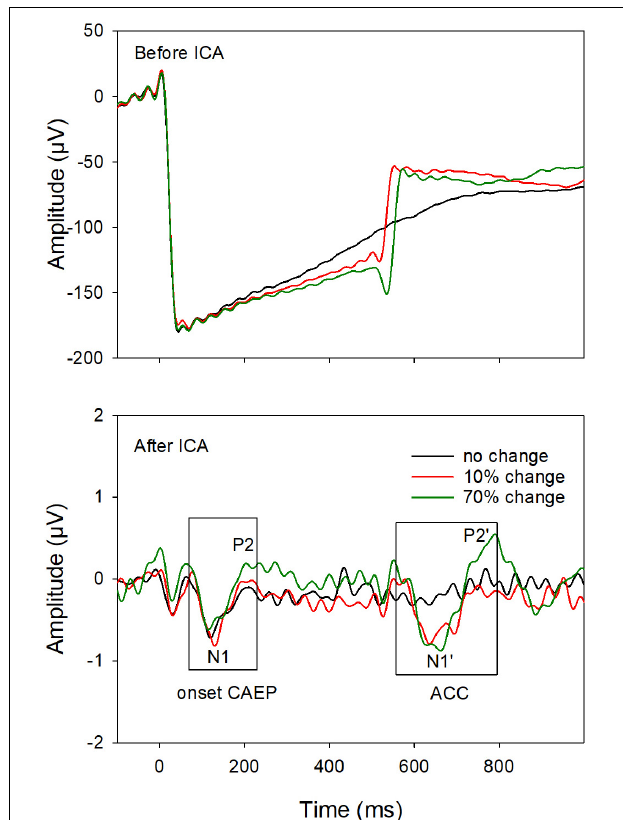
FIGURE 1 | An example of event-related-potentials (ERPs) before (top) and after (bottom) artifact removal using the independent component (ICA) analysis. After removing the artifacts, the onset-CAEP and ACC are revealed. The response peaks (N1 and P2 for the onset-CAEP and the N1 (cid:48) and P2 (cid:48) for the ACC, as shown in the two boxes) are